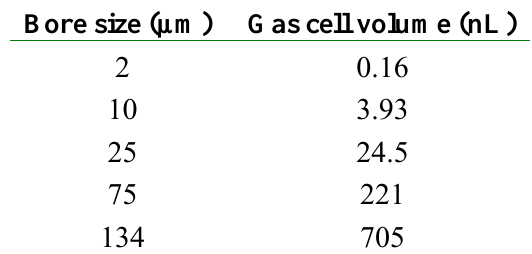
Table 1. Gas cell bore sizes with their corresponding volumes at fixed path length of 50